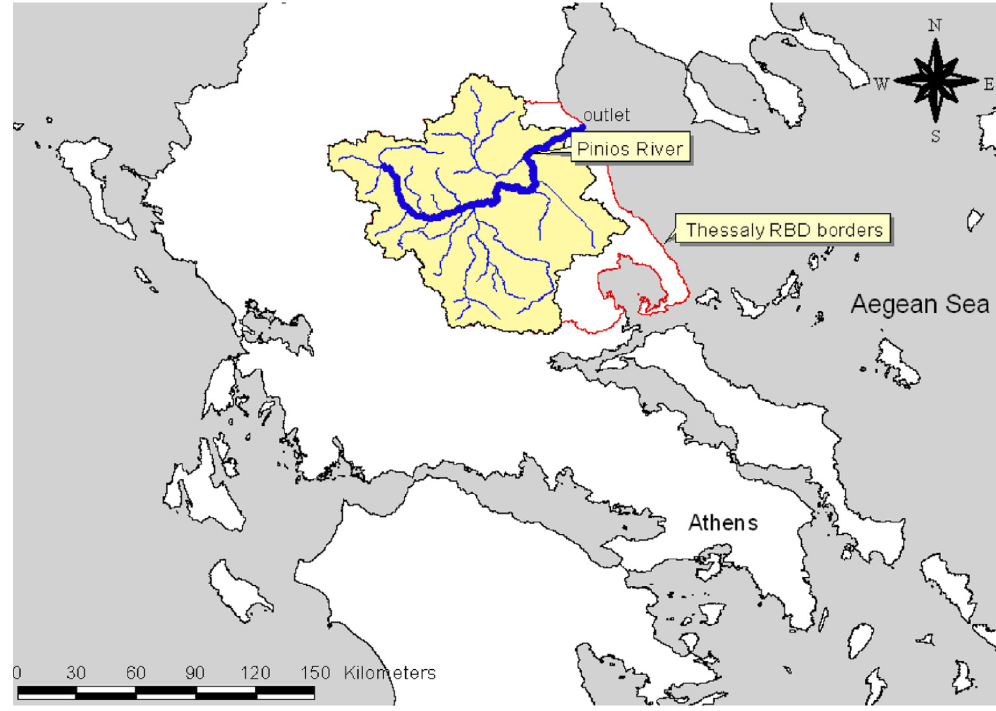
Figure 1. Study area of the research.